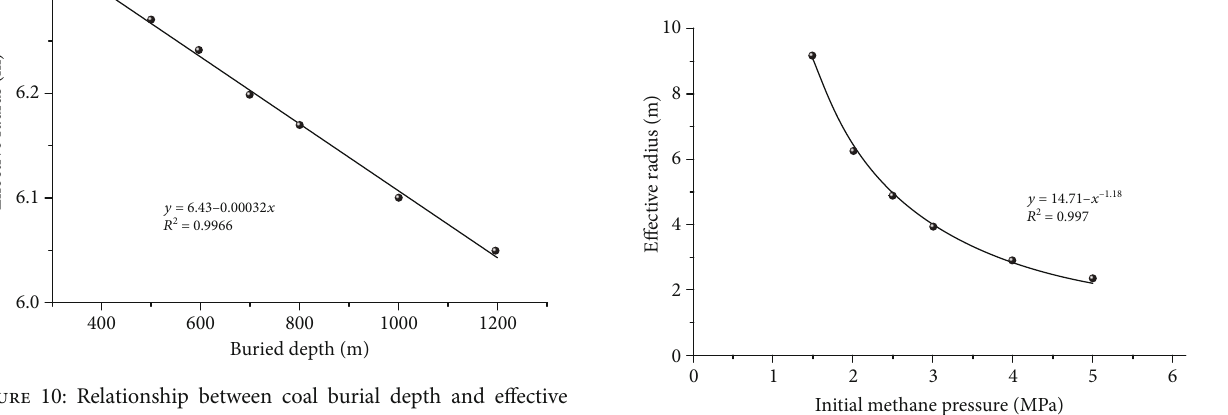
Figure 10: Relationship between coal burial depth and e ff ective radius.